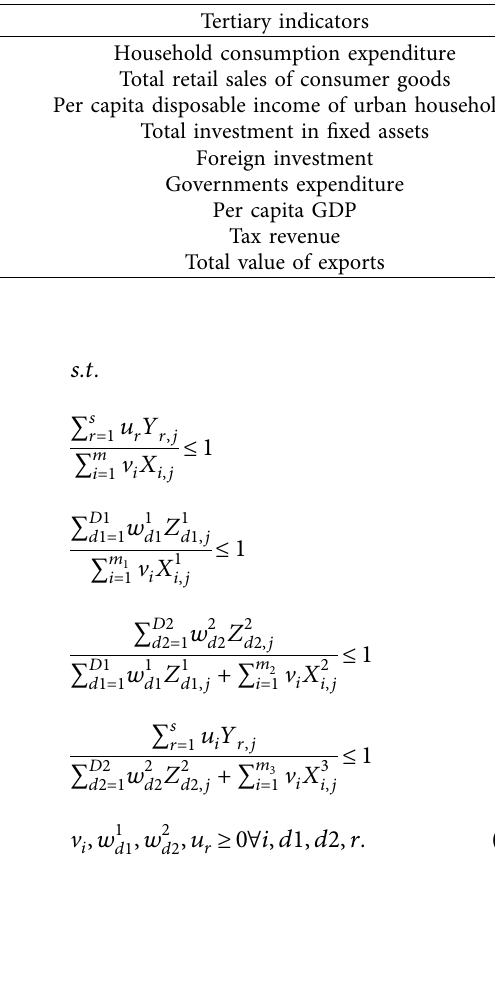
Table 4: Evaluation indicator system of regional economic development